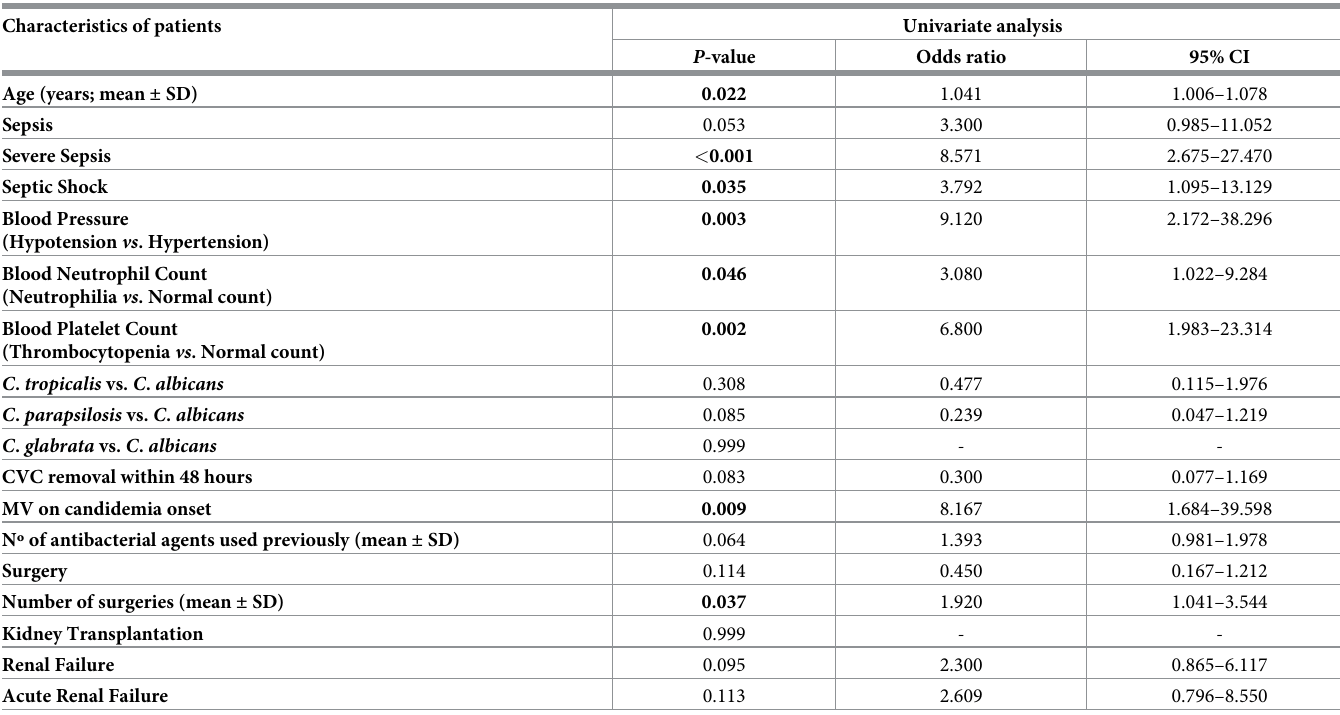
Table 5. Univariate logistic regression analysis of risk factors for 30-day